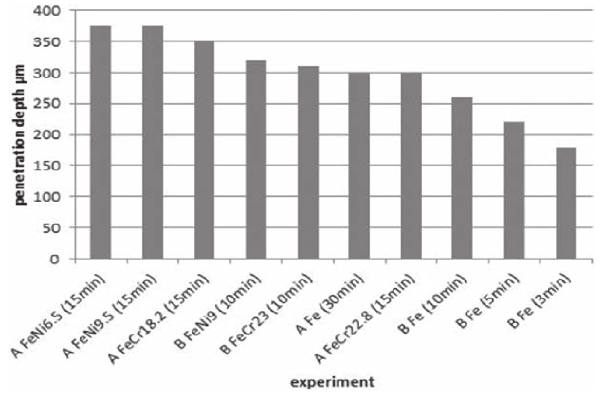
Fig. 8: Penetration depths for all